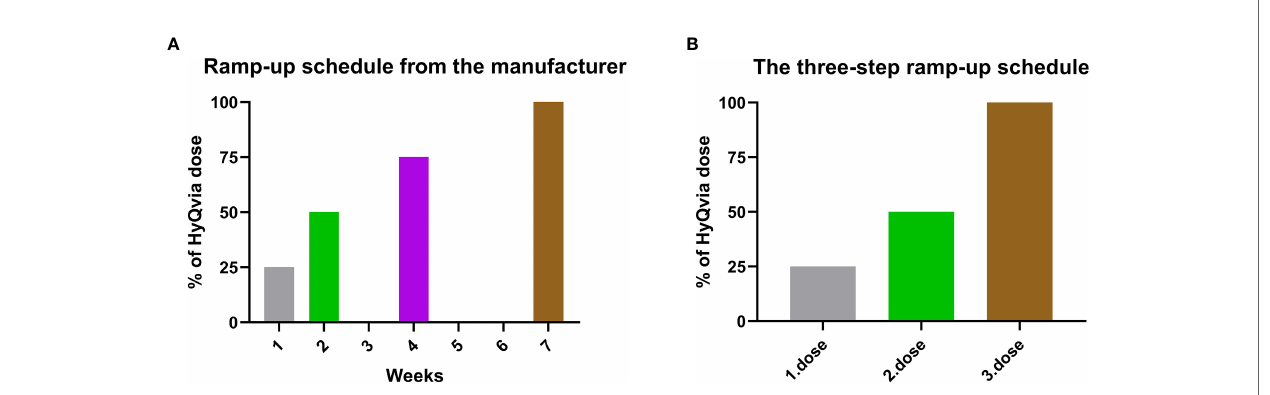
FIGURE 1 | The American HyQvia dosing guidelines compared to the three-step ramp-up schedule. (A) The American HyQvia dosing guidelines showing that the 7-week ramp-up period is planned at set weeks. (B) The three-step ramp-up schedule is not given at set weeks. Dose 1 and 2 can be given with a minimum of one day apart, and the third dose is given after the patients have received their electrical infusion pumps from the local ‘ Medical equipment supplier ’ , which often takes a few weeks. The 75% of total HyQvia dose is skipped in the three-step ramp-up schedule compared to the American HyQvia dosing